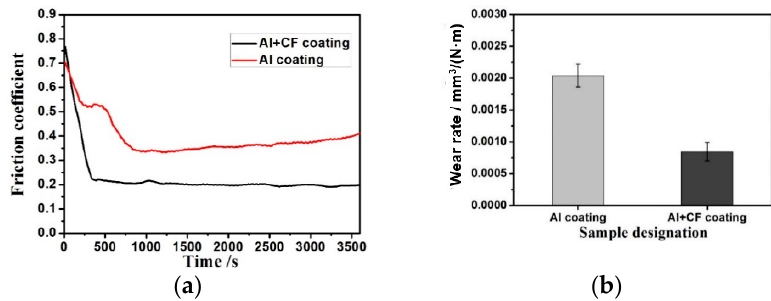
Figure 8. Wear testing results of Al coating and Al-CF composite coating, ( a ) friction coefficient curves, and ( b ) wear rate.